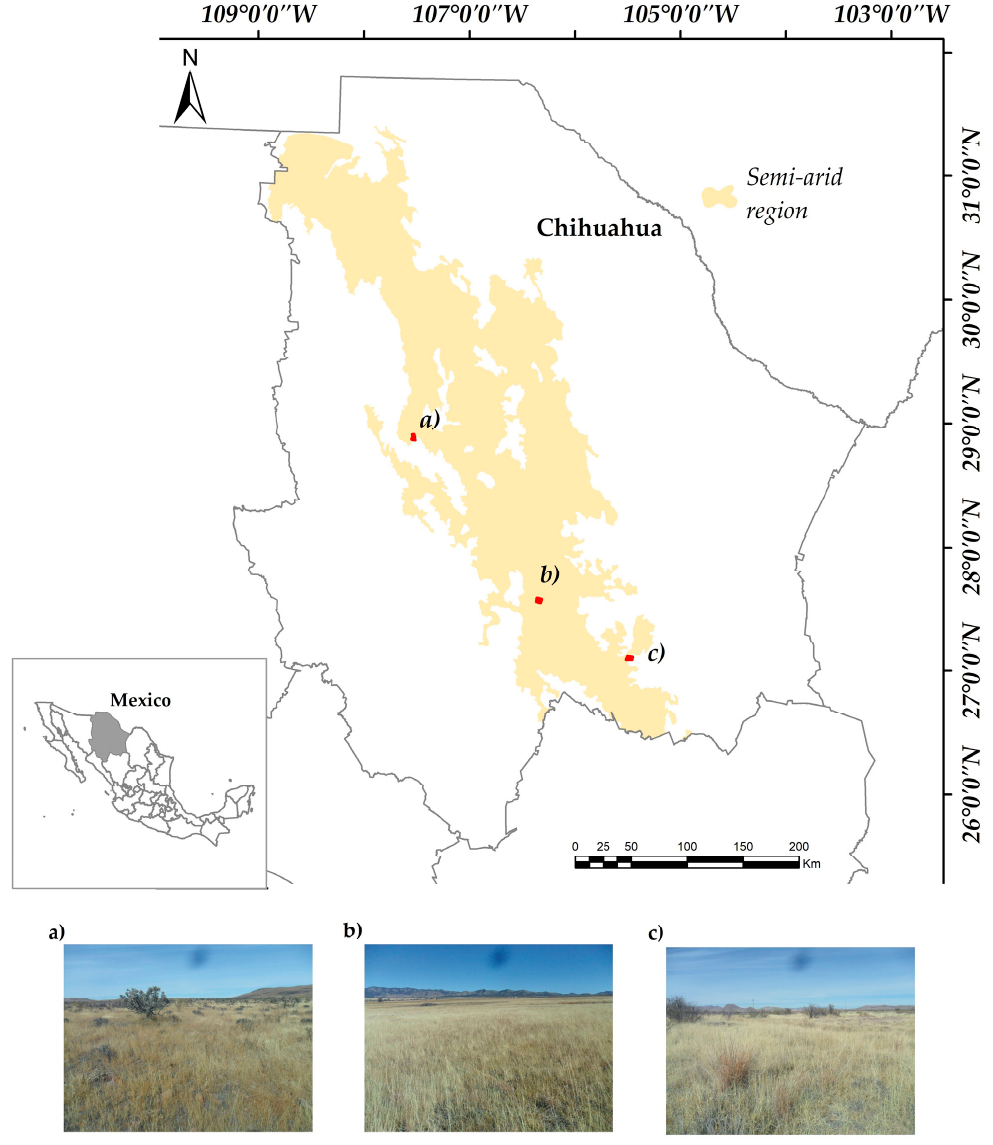
Figure 1. Location of the three permanent monitoring sites. The pictures depict representative biomass features of the sites. ( a ) Teseachi; ( b ) El Sitio; ( c ) Eden.